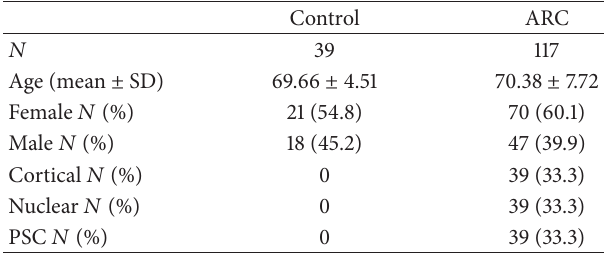
Table 1: Demographic information of study